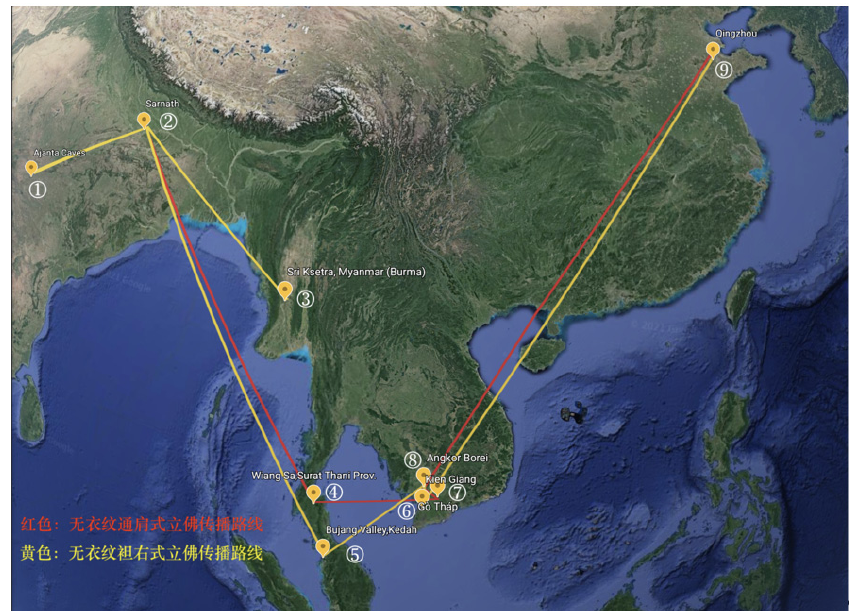
Figure 10. The schematic diagram of transmission routes of standing Buddha statues with diapha- nous robes (type A and type C). ① Ajanta Caves, India; ② Sarnath, India; ③ Sri Ksetre, Myan- mar; ④ Wiang Sa, Surat Thani Prov., Malay Peninsula; ⑤ Bujang valley, Kedah, Malay Peninsula; ⑥ Nen Chua, Kien Giang Prov., Southern Vietnam; ⑦ Mekong Delta; ⑧ Vat Romlok Site, Ang- kor Borei, Cambodia; ⑨ Longxing Temple Site, Qingzhou, Shandong Peninsula, China; Red lines: transmission route of type A statues; yellow lines: transmission routes of type C